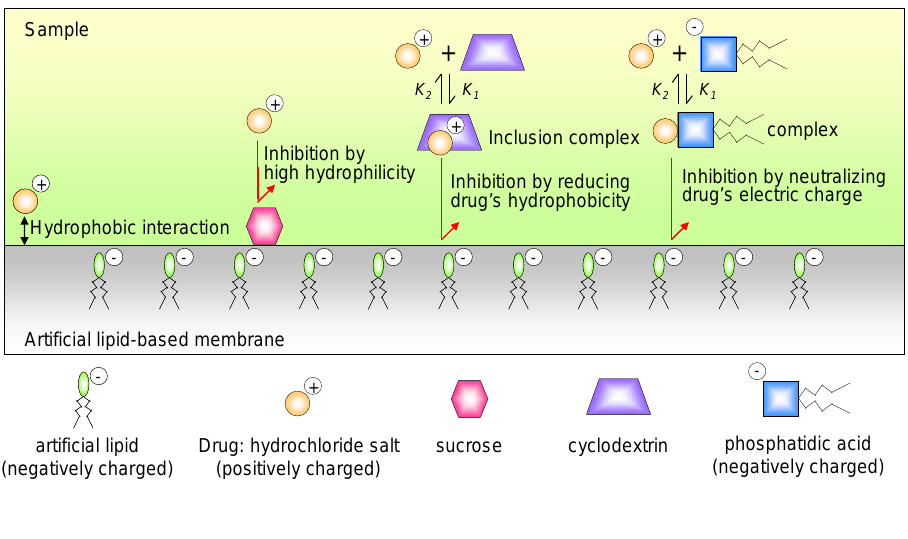
Figure 23. Possible mechanisms of suppression effect of bitter-masking materials (Reprinted with permission from the Institute of Electrical Engineers of Japan